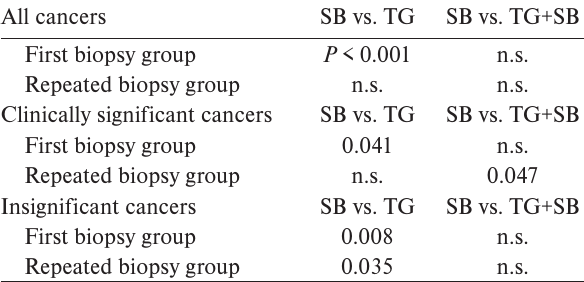
Table 3. P -values in the comparison of targeted and systematic